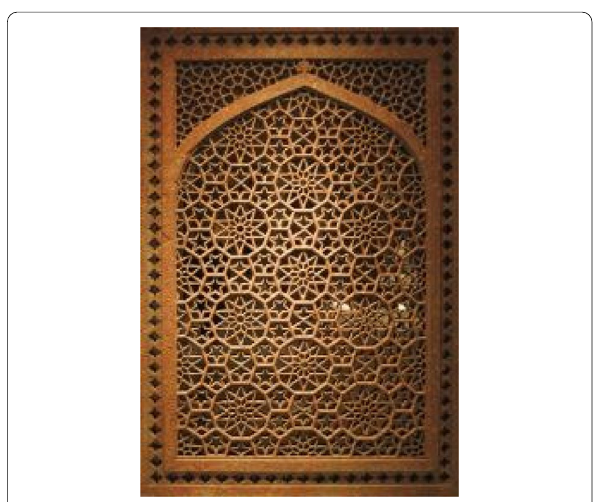
Fig. 3 A latticework of Mughal at the Metropolitan Museum of Art,